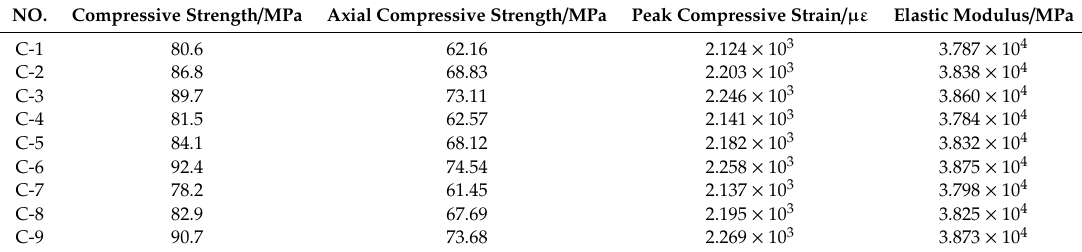
Table 1. Mechanical parameters of concretes for shaft lining structures.